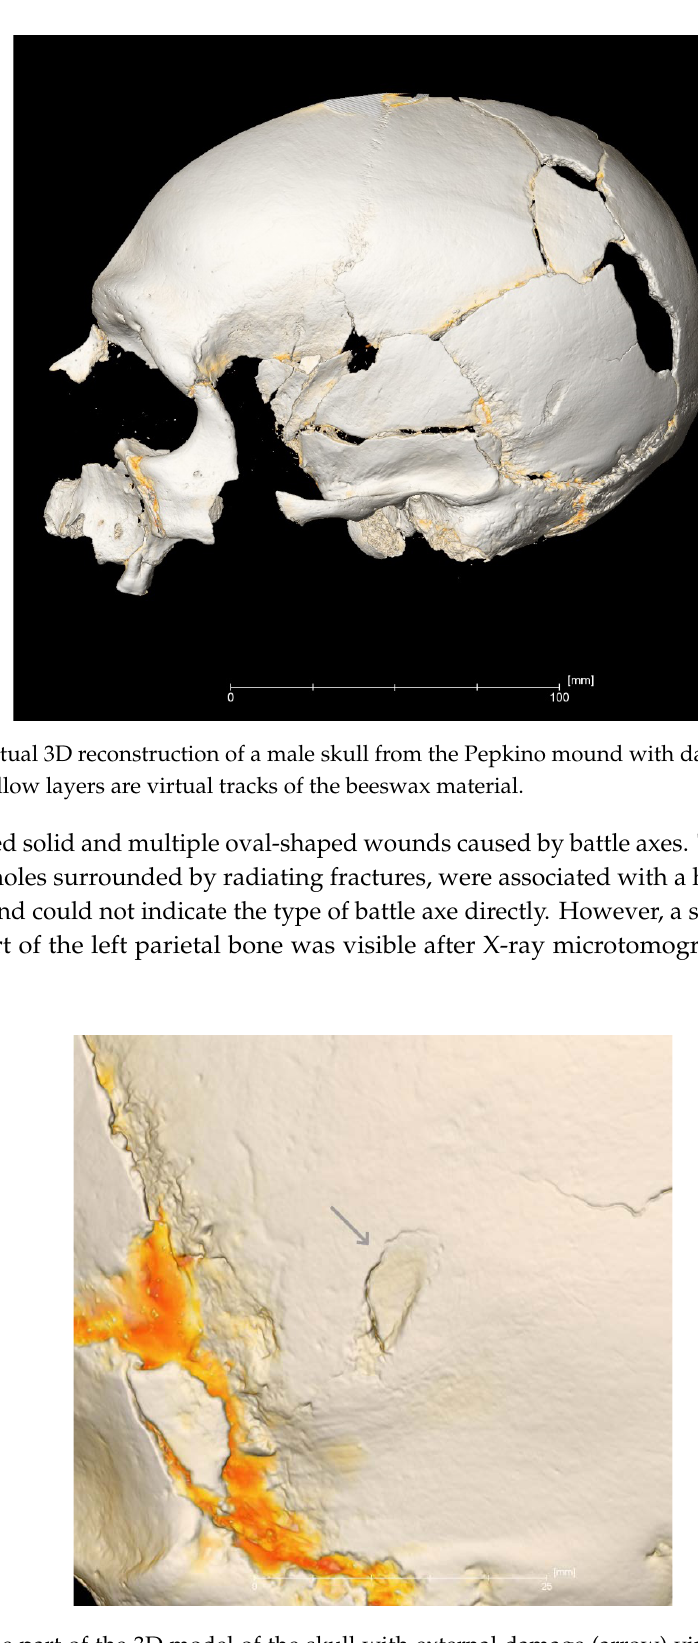
Figure 5. The part of the 3D model of the skull with external damage ( arrow) virtually cleaned of restoring beeswax. The yellow layers are the virtual remains of the beeswax material. The resolution is 80 μm.